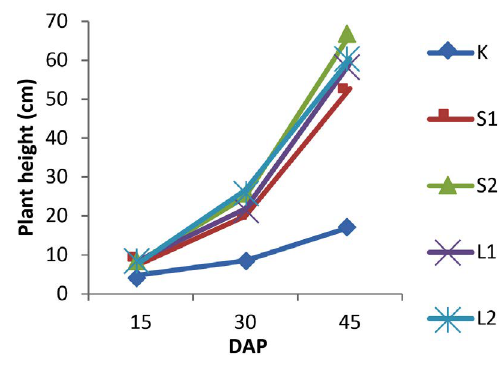
Fig. 1. Induced compost effect on the plant height . K = control; S1 = Cellulolytic (10%); S2=Cellulolytic (20%); L1 = Ligninolytic (10%); L2 = Ligninolytic (20%).